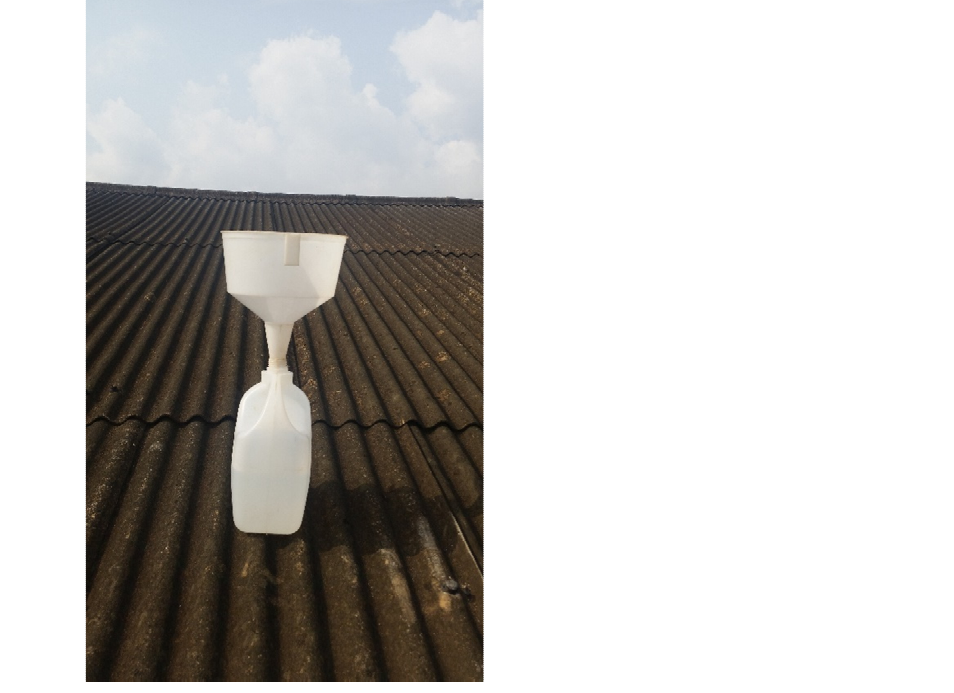
Figure 2. 10-inch funnel attached to a 5 L plastic container for measuring total depositions.